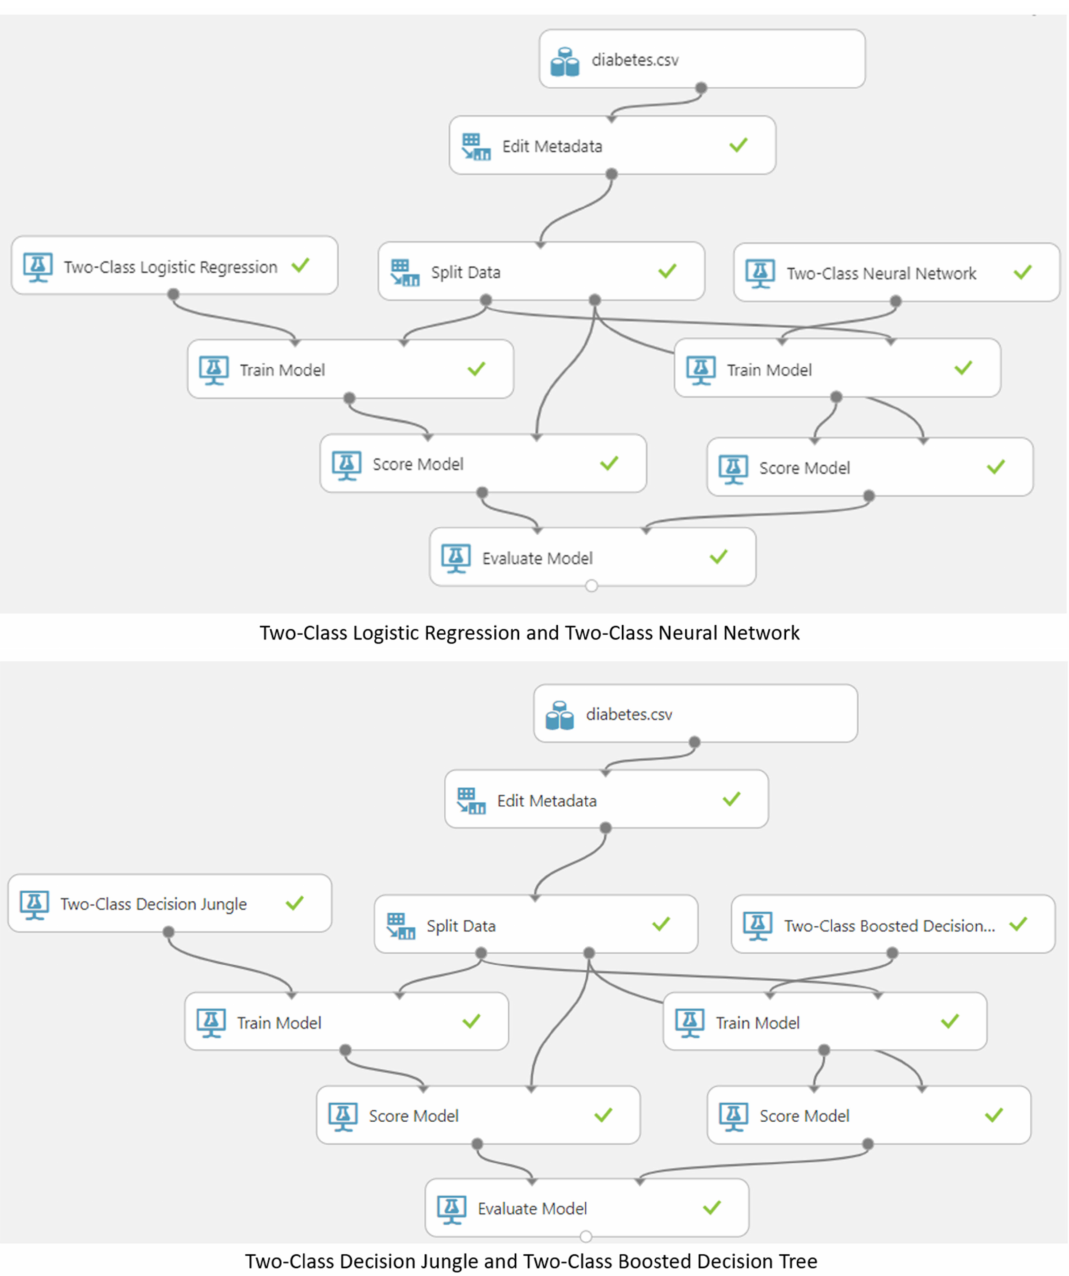
Figure 8. Cross-validation and comparison of the four different